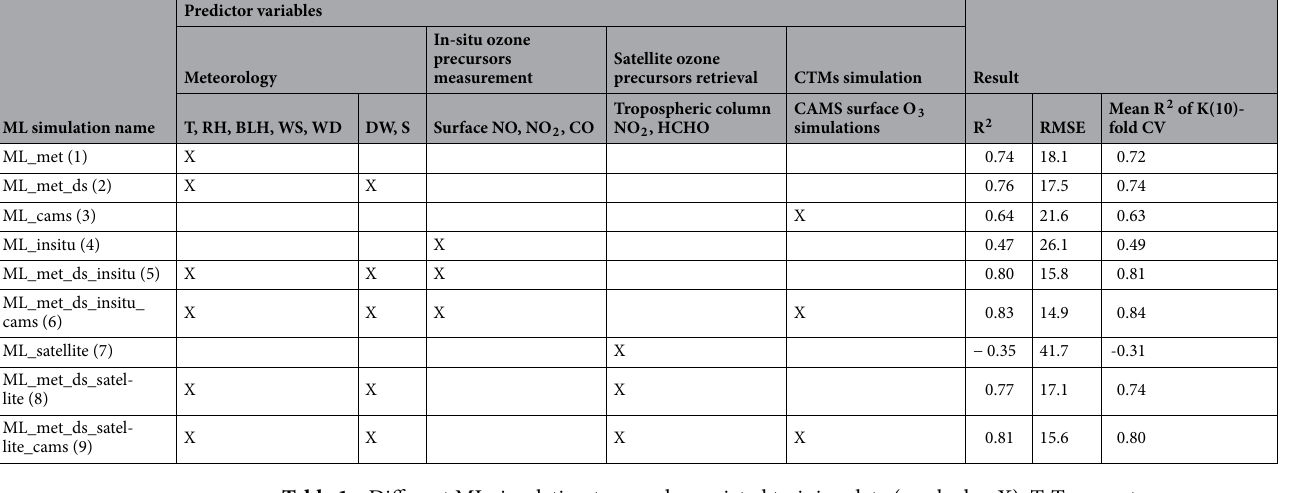
Table 1. Different ML simulation type and associated training data (marked as X). T-Temperature, RH-Relative Humidity, BLH-Boundary Layer Height, WS-Wind Speed, WD-Wind Direction, DW-Day of Week, S-Season, NO-Nitric oxide, NO 2 -Nitrogen Dioxide, CO-Carbon Monoxide, O 3 -Ozone and HCHO- Formaldehyde. The index of different ML simulation types is given in brackets in the first column, to which we refer in Fig. 2. The performance of each ML simulation with fewer days case (689 days) at lothstrasee station is shown in the last three